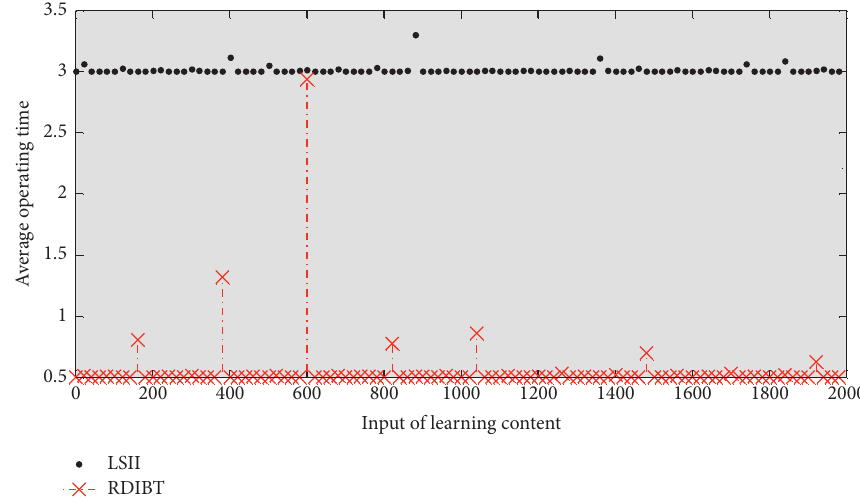
Figure 7: The average operation time for changing the input volume of learning